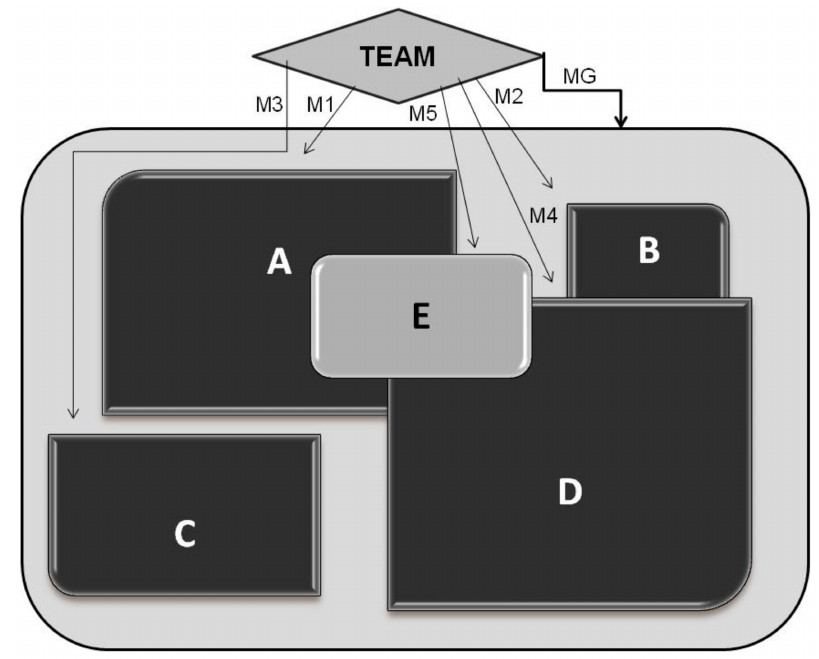
Figure 5. Specific strategy in a public participation